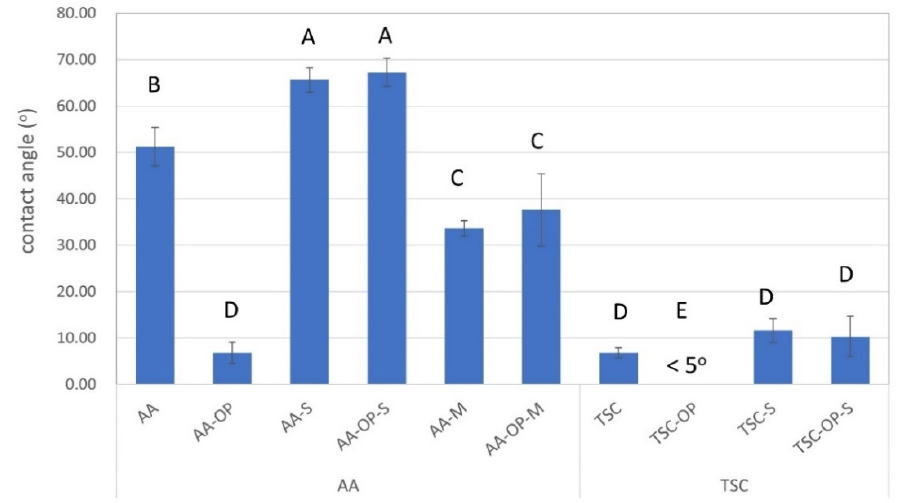
Figure 4. Mean values of the contact angles in all experimental groups. Different upper-case letters indicate a significant difference ( p < 0.05) among the experimental groups.